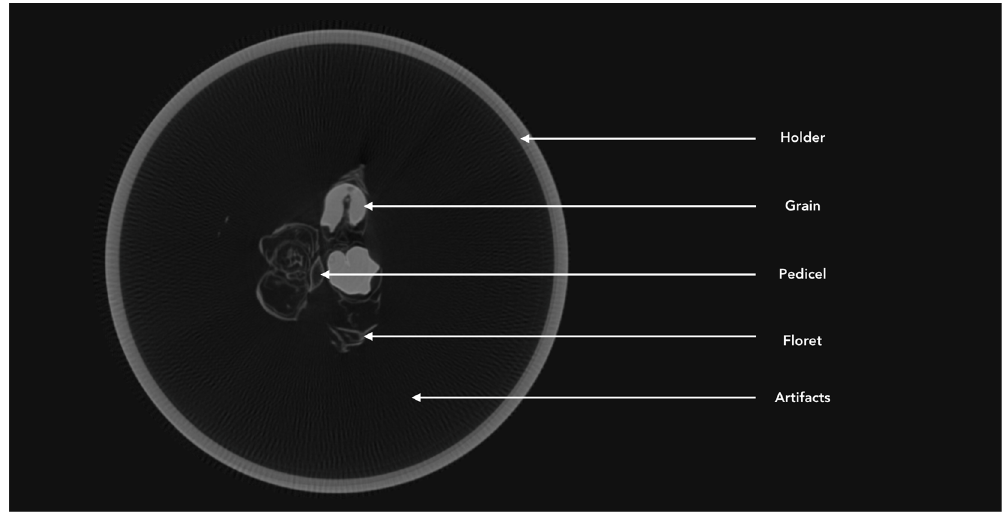
Figure 2. A slice image sample and representations of wheat spike tissue.